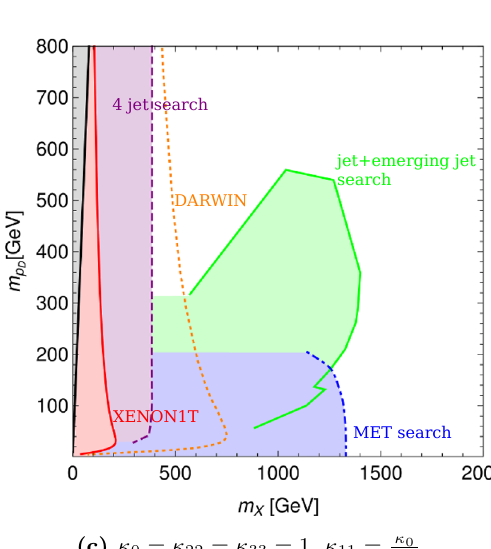
Figure 10. Constraints on dark QCD in the m X − m p dot-dashed blue and dashed purple regions are excluded from the emerging jet, MET and four jet searches, the red region from XENON1T. The dotted orange line shows the expected DARWIN exclusion limit. Above the black lines the dark pion mass is larger than the mediator mass, while above the loosely dotted line the dark pion mass is larger than 100